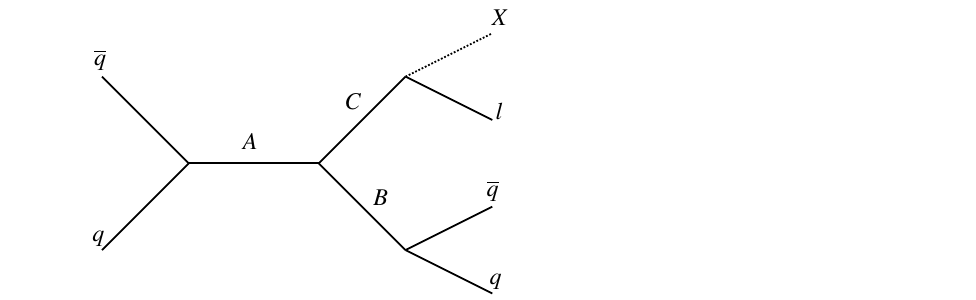
Figure 1. A schematic representation of the decay a heavy particle A to two other particles, B and C